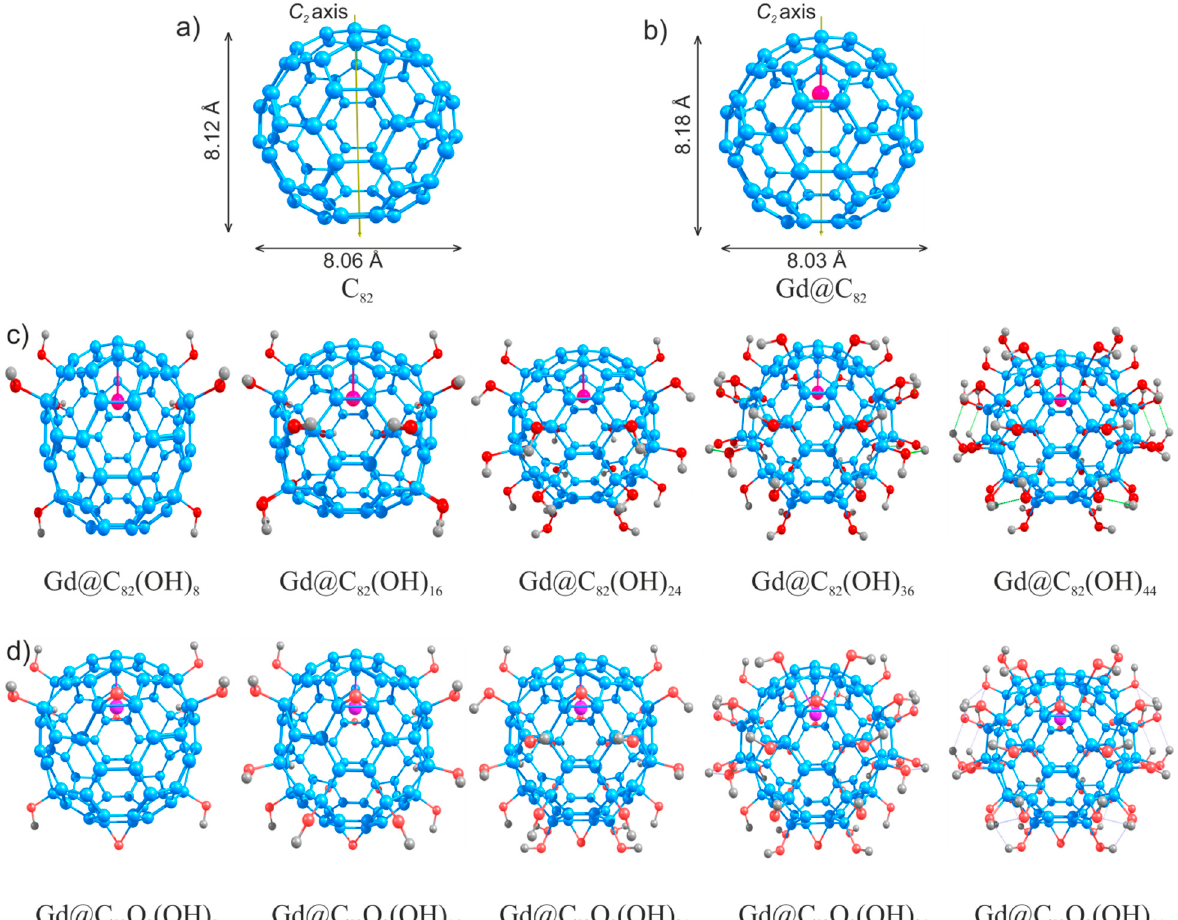
Figure 1. C 82 fullerene related clusters oriented following C 2v symmetry. ( a ) C 82 , ( b ) Gd@C 82 , ( c ) C 82 O x (OH) y , and ( d ) Gd@C 82 O x (OH) y ( x = 0, 3; y = 8, 16, 24, 36, 44). Carbon, gadolinium, oxygen, and hydrogen atoms are shown in blue, fuchsia, red, and gray colors, respectively. The carbon cage lengths along the second-order axis for C 82 and Gd@C 82 are 8.12 and 8.18 Å with the widths 8.06 and 8.03 Å, respectively.